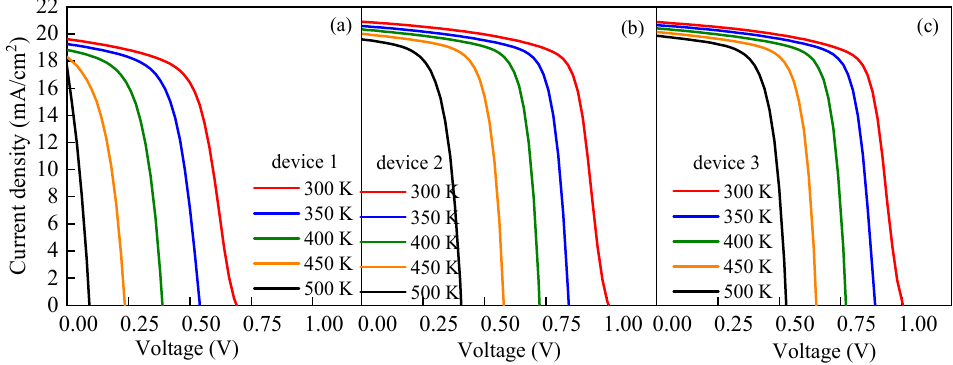
Figure 19. Effects of the temperature on the cell performance: ( a ) J-V characteristics of device 1 at different temperatures, ( b ) J-V characteristics of device 2 at different temperatures, and ( c ) J-V characteristics of device 3 at different temperatures.